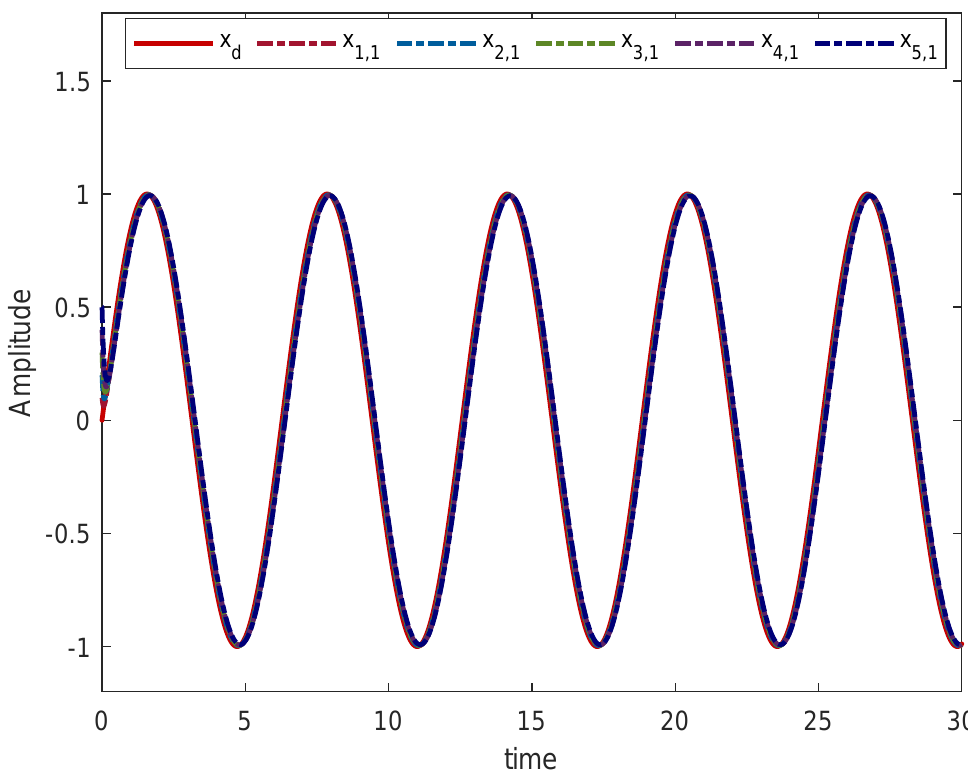
Figure 13. The trajectories of x d and x i ,1 ( i = 1, · · · ,5 ) based on the algorithm proposed in this paper.